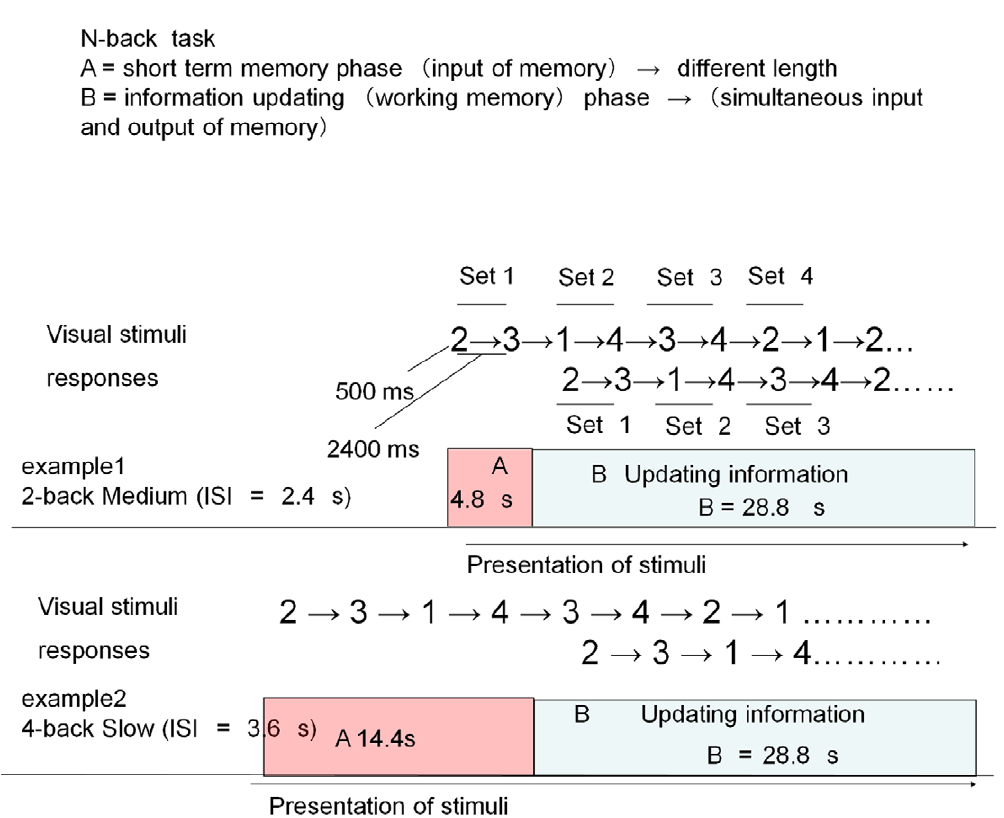
Figure 2. An example of trials illustrating the schematic representation of tasks of different memory loads and the speeds and the strategies used to complete them. Participants were instructed to update memory N by N, not one by one. Each block of the N-back task consisted of phase A and phase B. Phase A was a short-term memory phase in which participants had to memorize presented numbers (input of memory). The length of this phase A differed and depended on the other conditions. Phase B was an information-updating (working memory) phase, and participants had to perform memory input and output simultaneously.